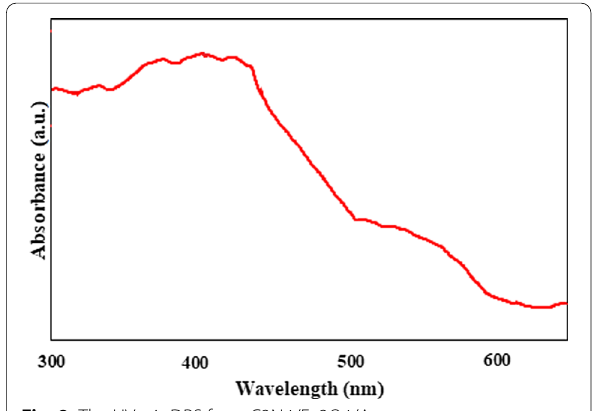
Fig. 8 The UV–vis DRS for g-C3N4/Fe3O4/Ag